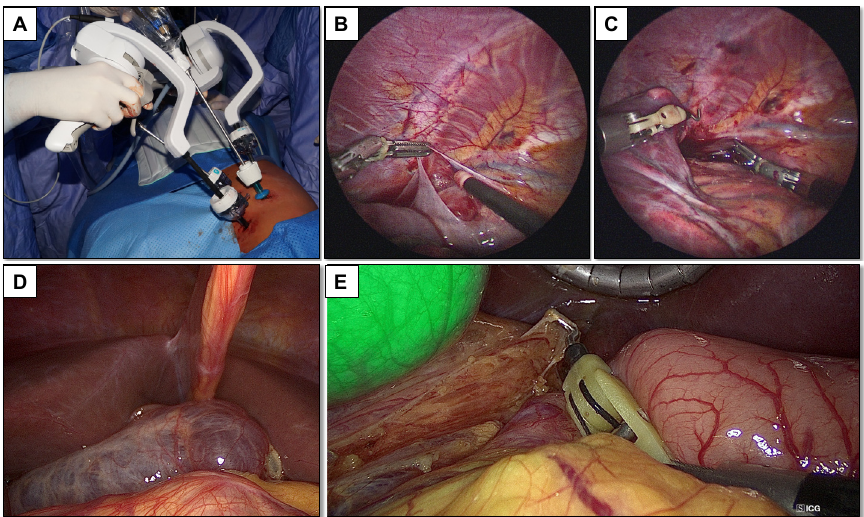
Figure 1. Thoracoscopic thymectomy performed using ArtiSential ® ( A ): some pictures taken from the surgical procedure in which the enhanced movements’ degrees of freedom even in a small operative space such as a pediatric thorax is clear ( B and C ). In ( D ) and ( E ) we can see the lymphangioma, resected using the wristed instrument with the aid of indocyanine green highlighting the biliary tree to avoid iatrogenic injury.